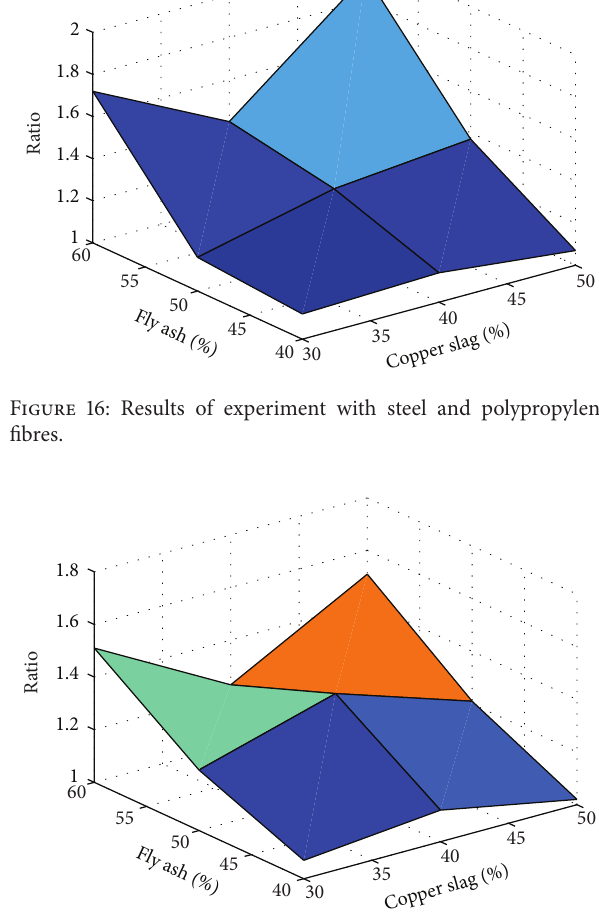
Figure 17: Typical dendrogram